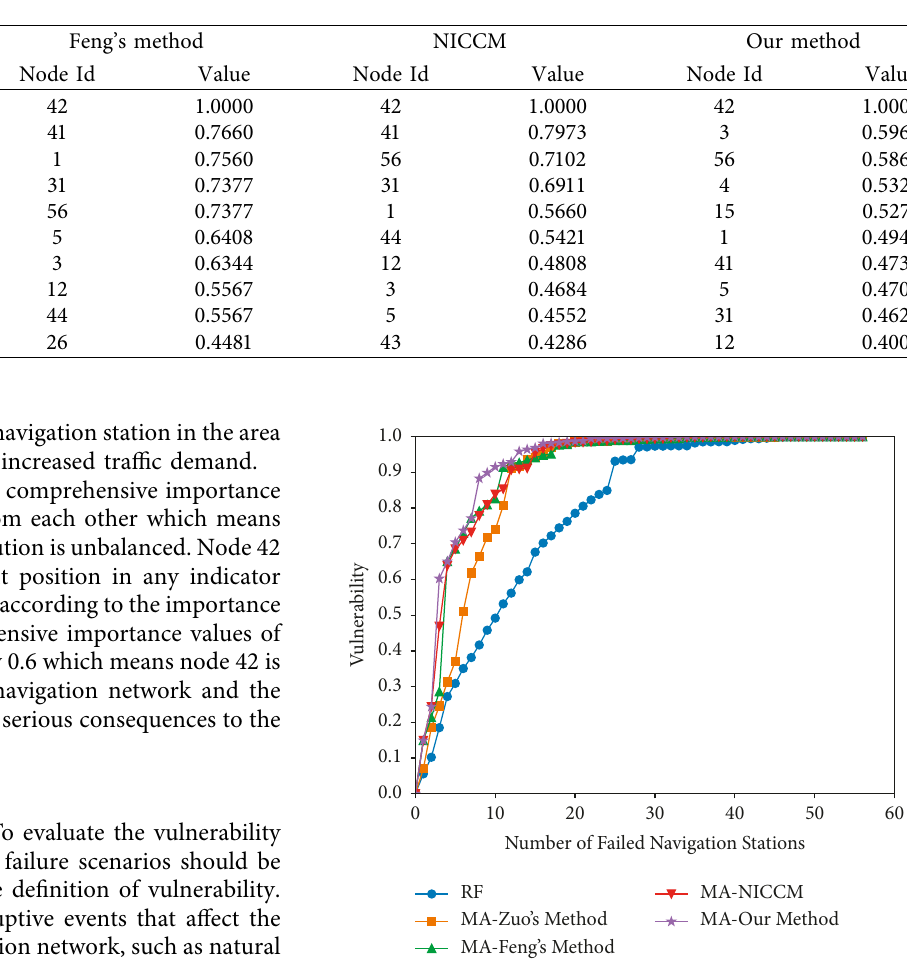
Figure 3: Vulnerability of navigation network under the failure scenarios of navigation stations with RF and MA in four methods, including Zuo’s method, NICCM, Feng’s method, and our